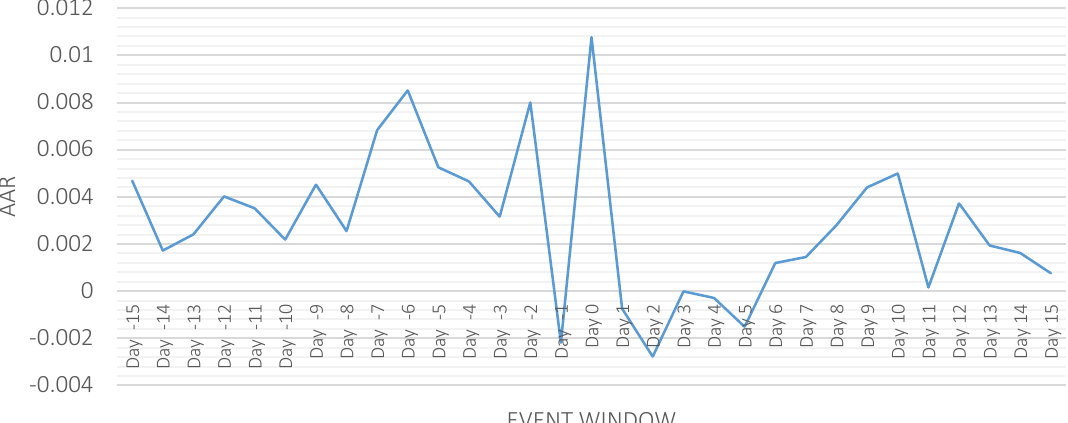
Figure 1. Average Abnormal Returns (AAR) for the event window of –15 to +15